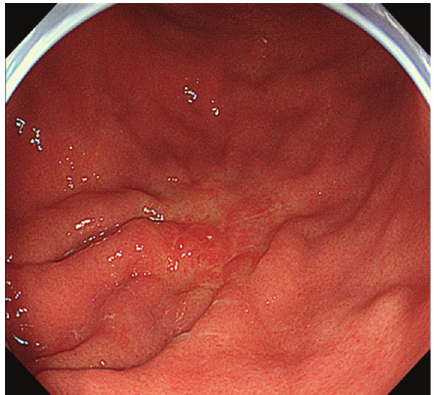
Figure 1: Gastrointestinal endoscopy revealed a depressed-type tumor in the greater curvature of the middle third of the stomach. Biopsy specimens showed a moderately to poorly di ff erentiated adenocarcinoma of the